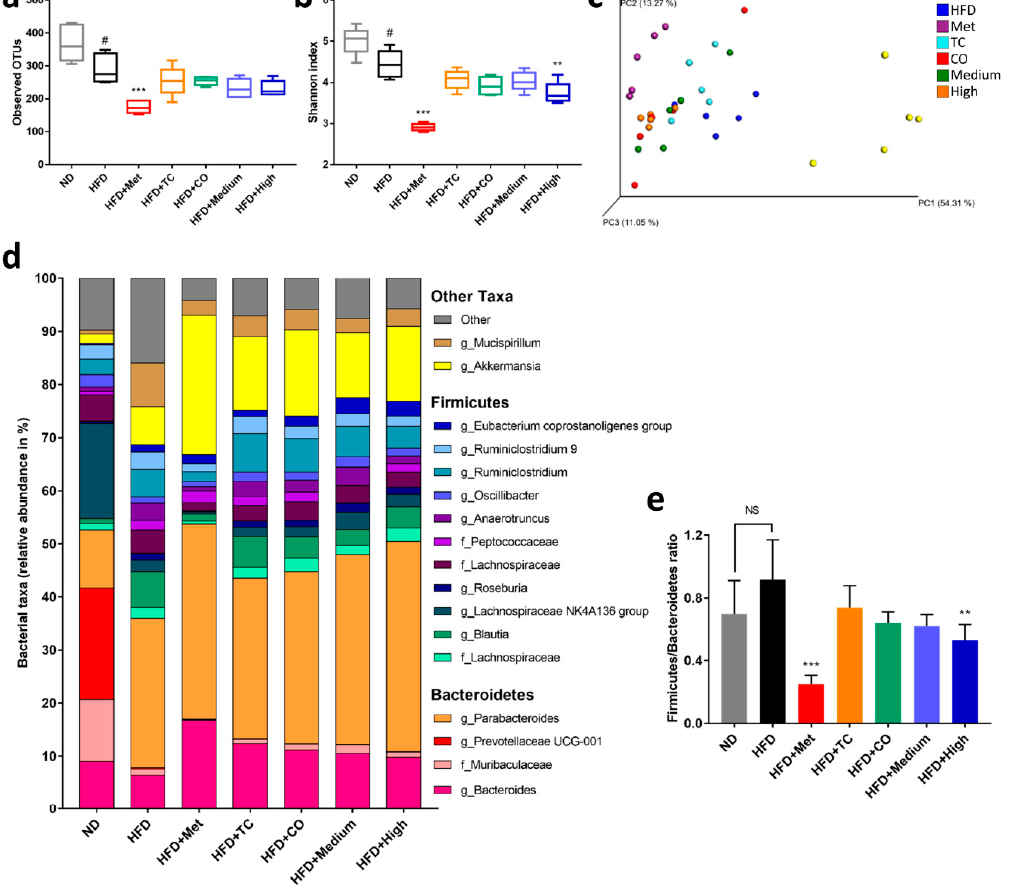
Figure 4. CO/TC formula alters gut microbiota composition in HFD-fed mice (n = 5). Alpha diversity assessed by ( a ) the Shannon index and ( b ) observed species. ( c ) Principal co-ordinate analysis (PCoA) of the weighted UniFrac metric for fecal microbiota. ( d ) Taxa summary of samples. OTUs were combined if their deepest taxonomic classi fi cations were identical, and taxa with less than 1% abundance were combined into ‘Other’. ( e ) The ratio of Firmicutes to Bacteroidetes . ( f ) The relative abundances of genus Akkermansia . ( g ) The relative abundances of genus Mucispirillum . ( h ) The relative abundances of genus Blautia . Data are reported as mean±SD and analyzed by one-way ANOVA with Tukey post-hoc test. # p < 0.05 was considered significant for ND vs. HFD. *** p < 0.001, ** p < 0.01, * p < 0.05 vs. HFD group. NS, represents no significance difference ( p > 0.05).